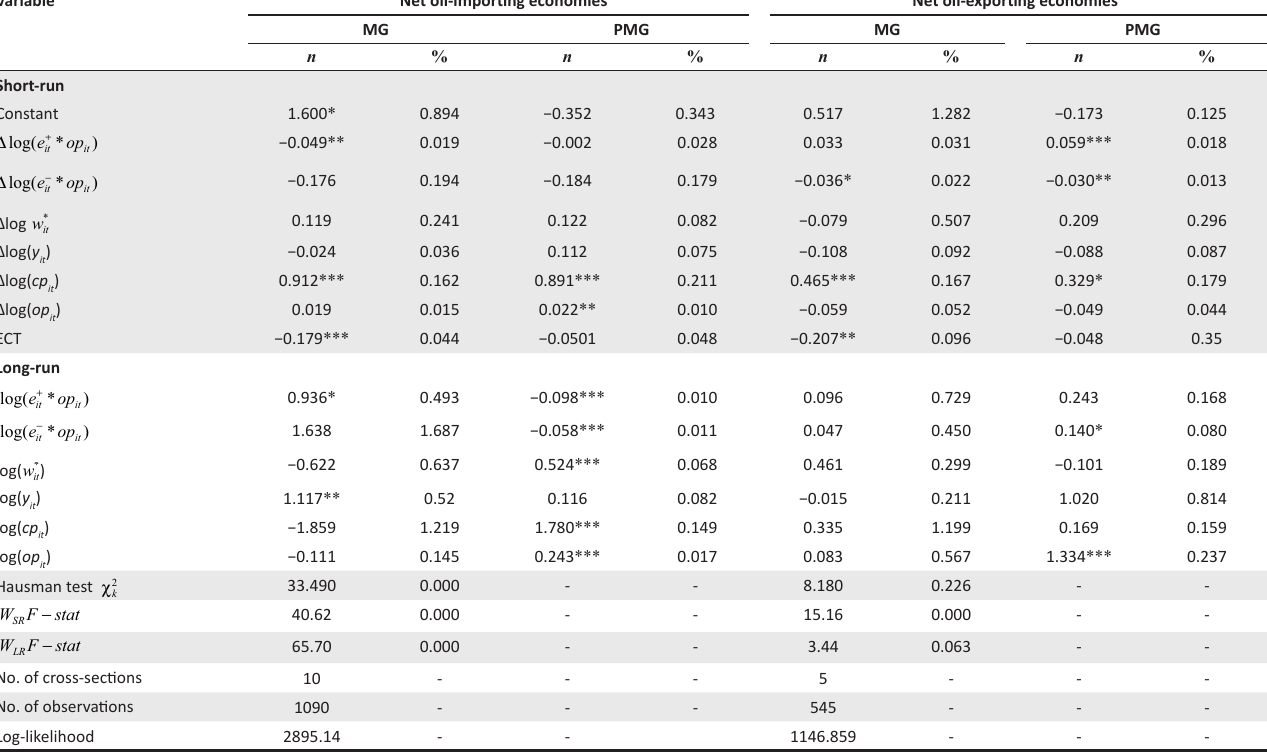
TABLE 5: Exchange rate pass-through panel regression results (asymmetric model with interaction term).